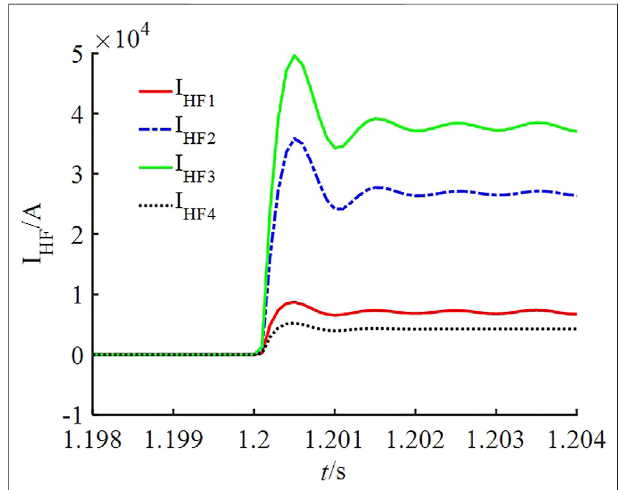
FIGURE 7 | High-frequency current waveforms for Line3